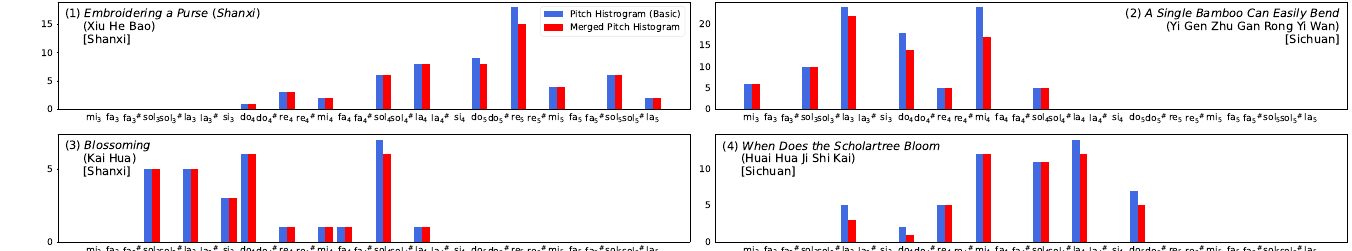
Figure 6. The movable do solfège-based basic and merged pitch histograms for four representative traditional Chinese anhemitonic pentatonic folk songs that do not present a perfect bell shape ( DoBell < 1), with the original names (Hanyu Pinyin) in curved brackets and the provinces of the origin in square brackets. Preserving only the anhemitonic pentatonic bins does not improve the bell-shapedness of the